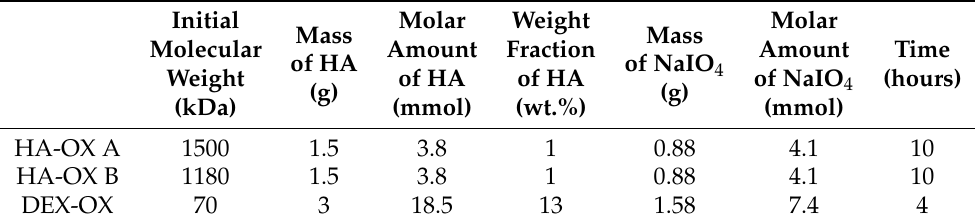
Table 2. Specification of polysaccharide oxidation conditions.